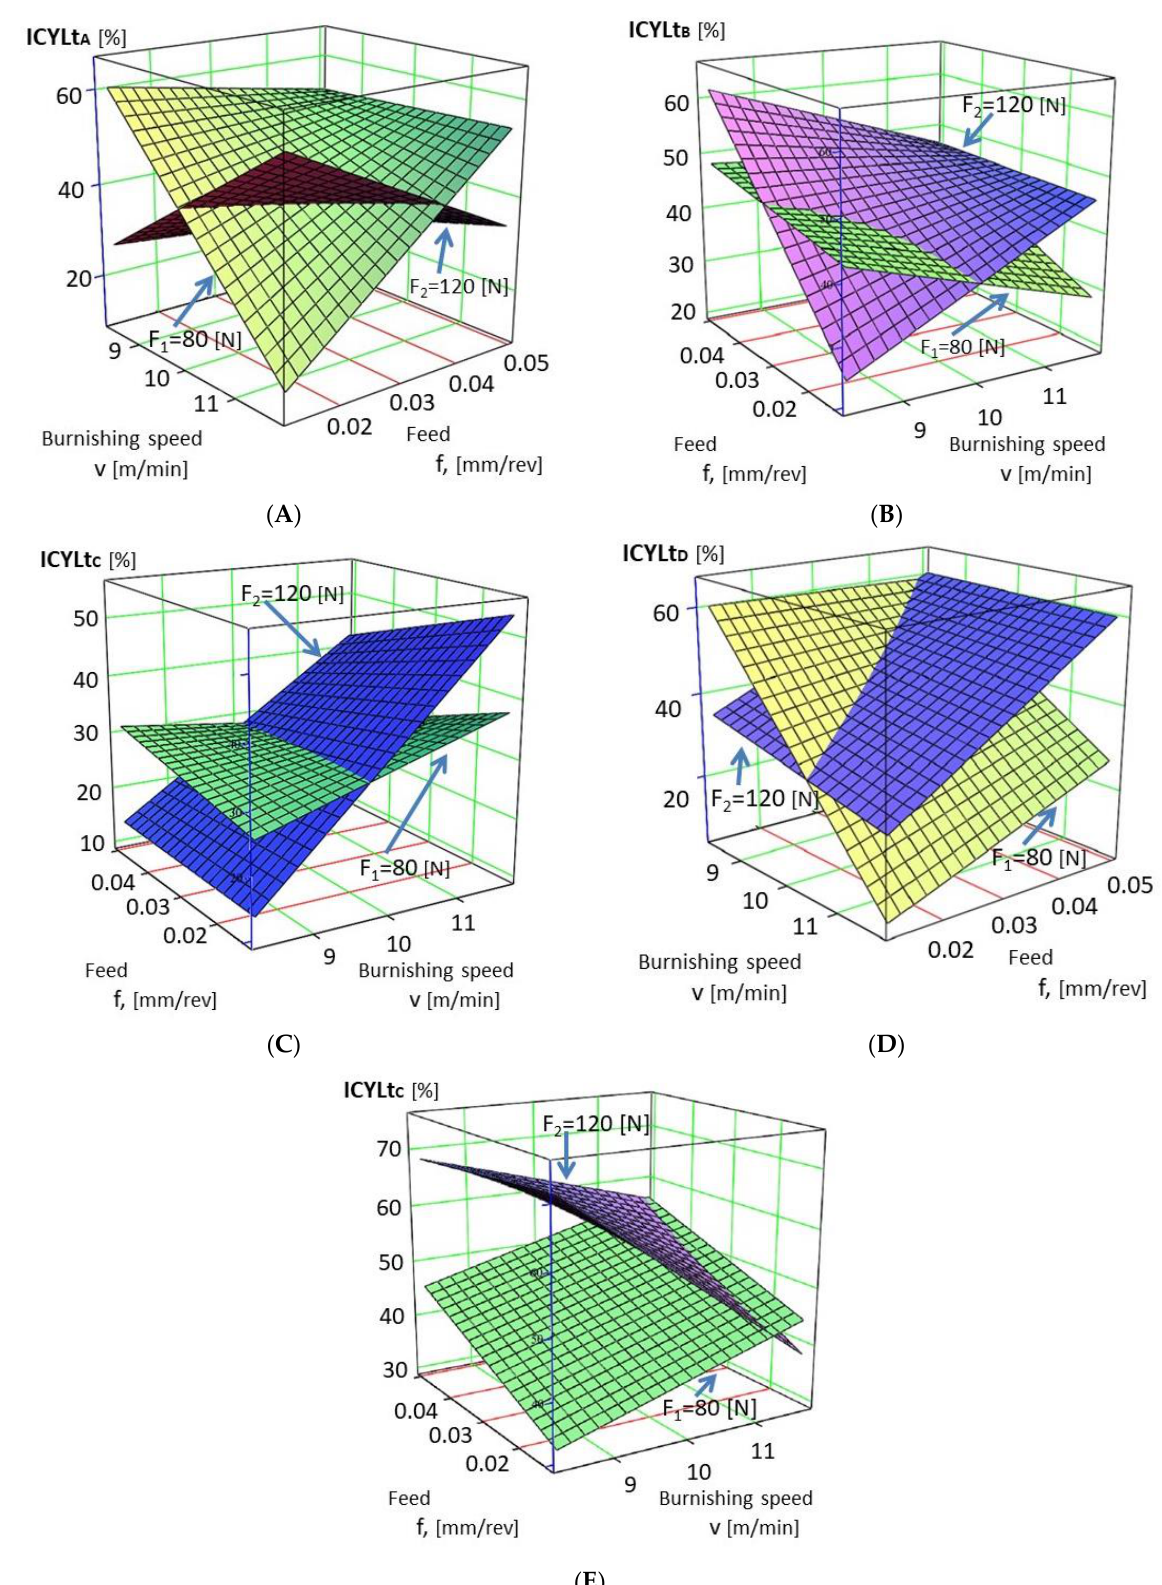
Figure 9. Graphs of empirical formulas Equations (10) – (14). ( A ) Plot of Equation (10). ( B ) Plot of Equation (11). ( C ) Plot of Equation (12). ( D ) Plot of Equation (13). ( E ) Plot of Equation (14). 𝐼𝐶𝑌𝐿𝑡 = 770.976 − 76.775 ∙ 𝑣 − 1.223 ∙ 10 4 ∙ 𝑓 − 6.963 ∙ 𝐹 + 1.426 ∙ 10 3 ∙ 𝑣 𝐴